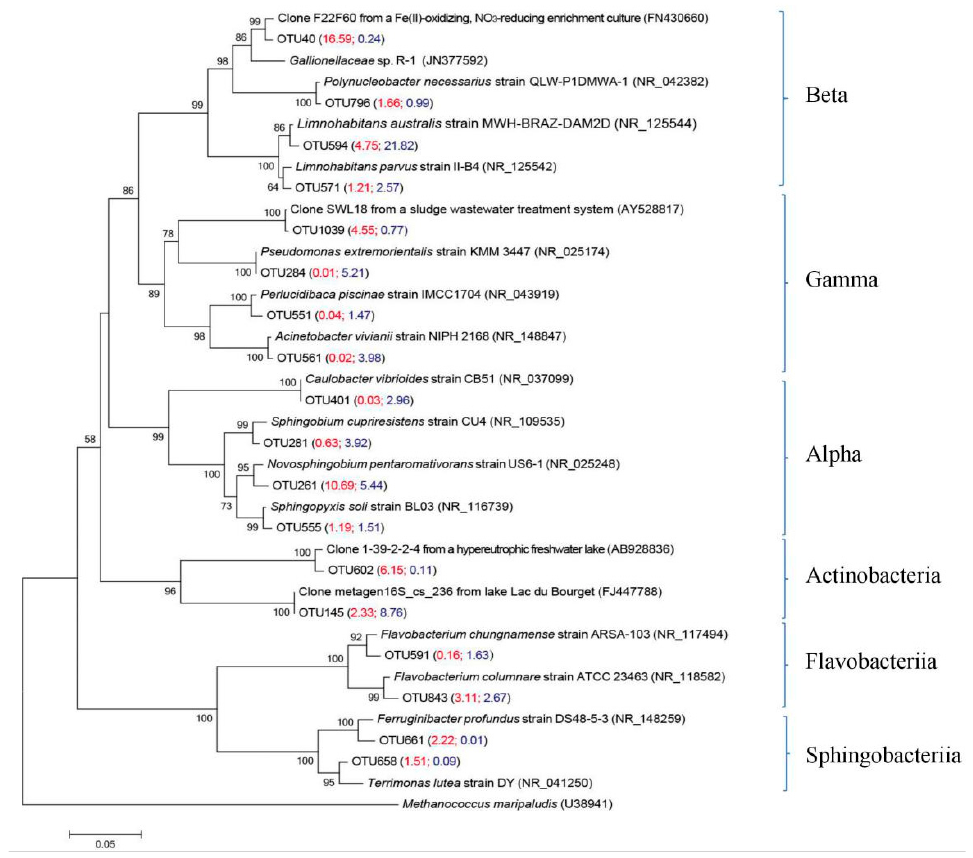
Figure 4. Neighbor-joining phylogenetic tree based on 16S rRNA gene sequences showing the phylogenetic relationship among the representative bacterial OTUs obtained in the >0.45 μ m size fraction and the 0.2–0.45 μ m fraction and reference 16S rRNA gene sequences retrieved from the NCBI GenBank. These bacterial OTUs were represented by the top 10 reads from the >0.45 μ m size fraction and the 0.2–0.45 μ m fraction. The scale bar represents the estimated number of nucleotide changes per sequence position. Percentage numbers on nodes refer to 1000 bootstrap resamplings conducted. Only values >50% are shown. Bold bacterial OTUs were obtained from the >0.45 μ m size fraction and the 0.2–0.45 μ m fraction. The numbers in parentheses indicate the percentage composition of reads in each sample in the following order: (BP, BF). Methanococcus maripaludis (U38941) was used as the outgroup. The number in parentheses represents the mean value of quadruplicate analyses.